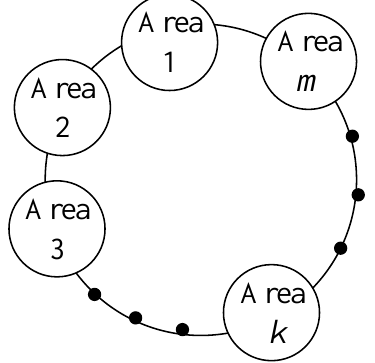
Figure 4. Diagram of a general m -area ring